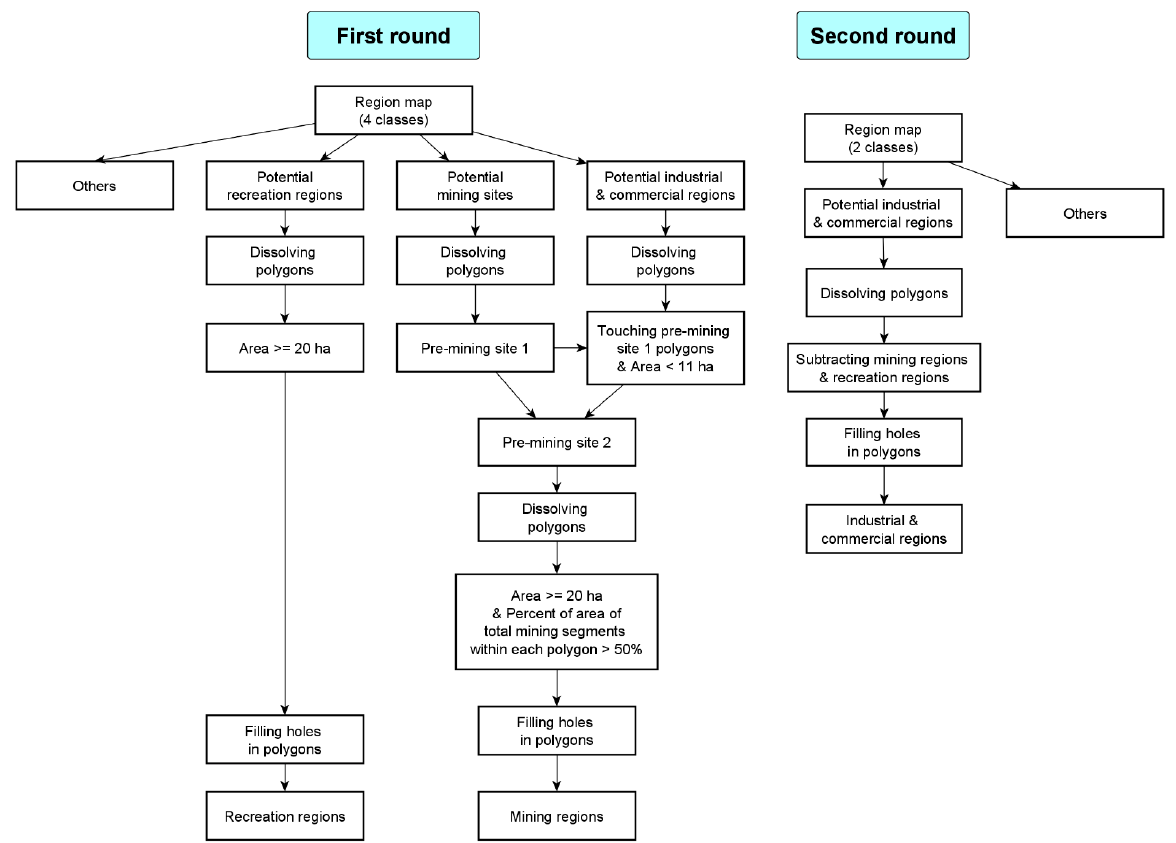
Figure 5. Process for extracting land use function regions.